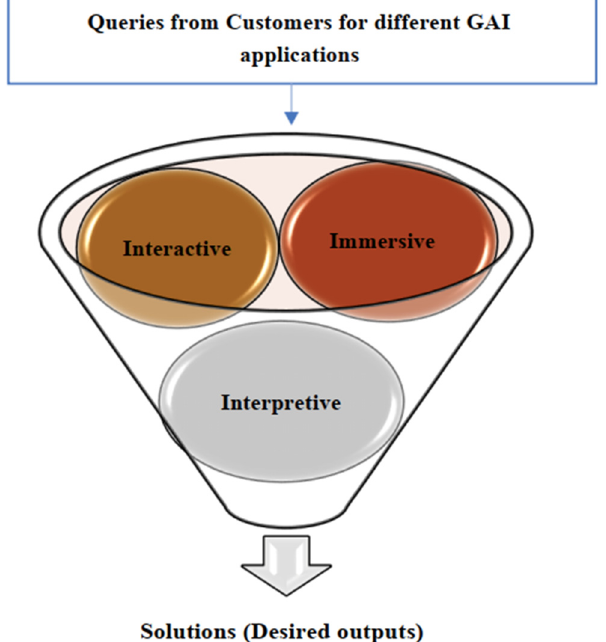
Figure 4. The 3I framework for GAI applications. Source: authors’ conception.